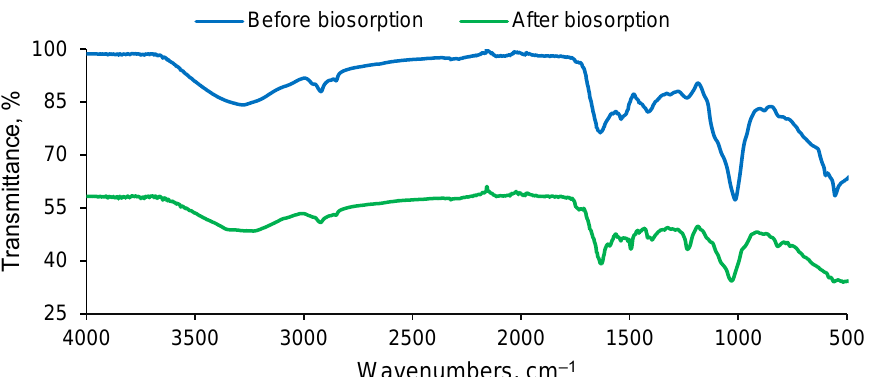
Figure 2. FTIR spectra of SPRBA 5% biosorbent before and after biosorption of ethacridine lactate from aqueous solution.